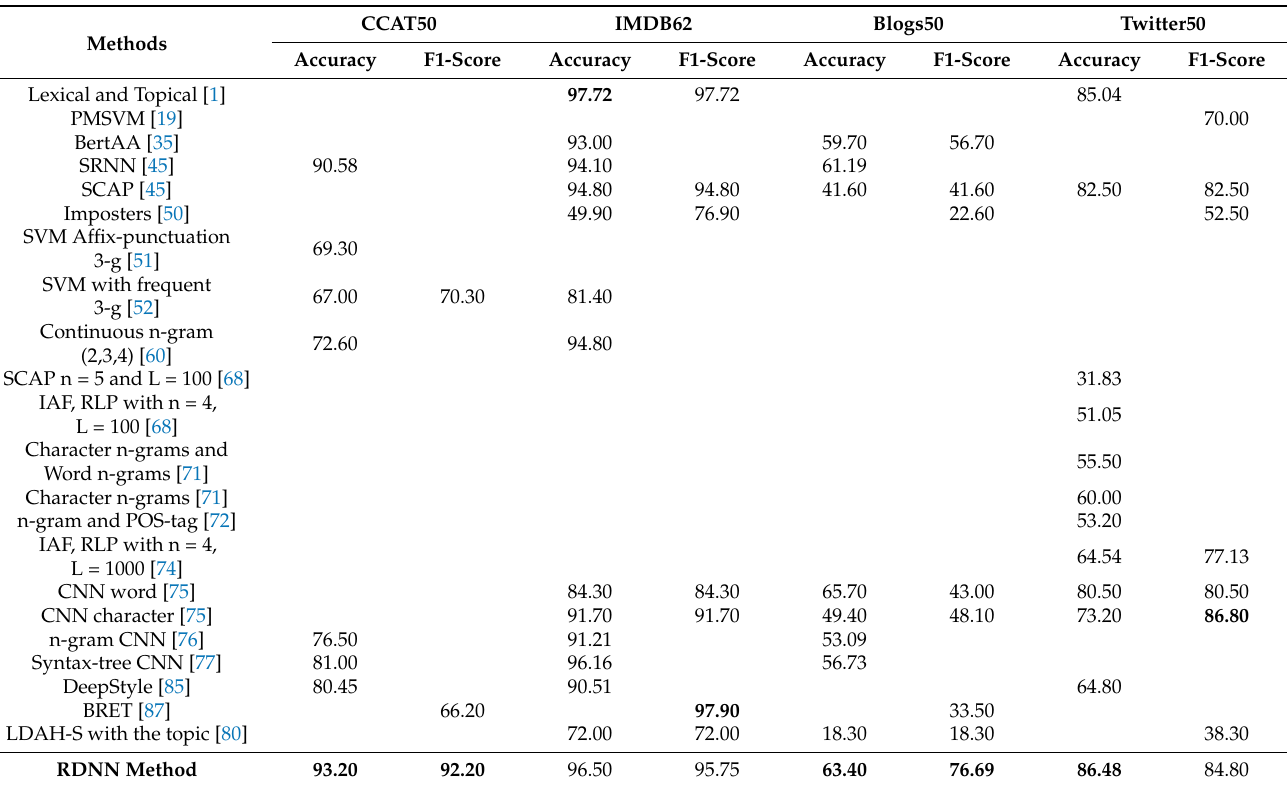
Table 4. Performance accuracy and F1 score of the RDNN and SOTA methods for PAA